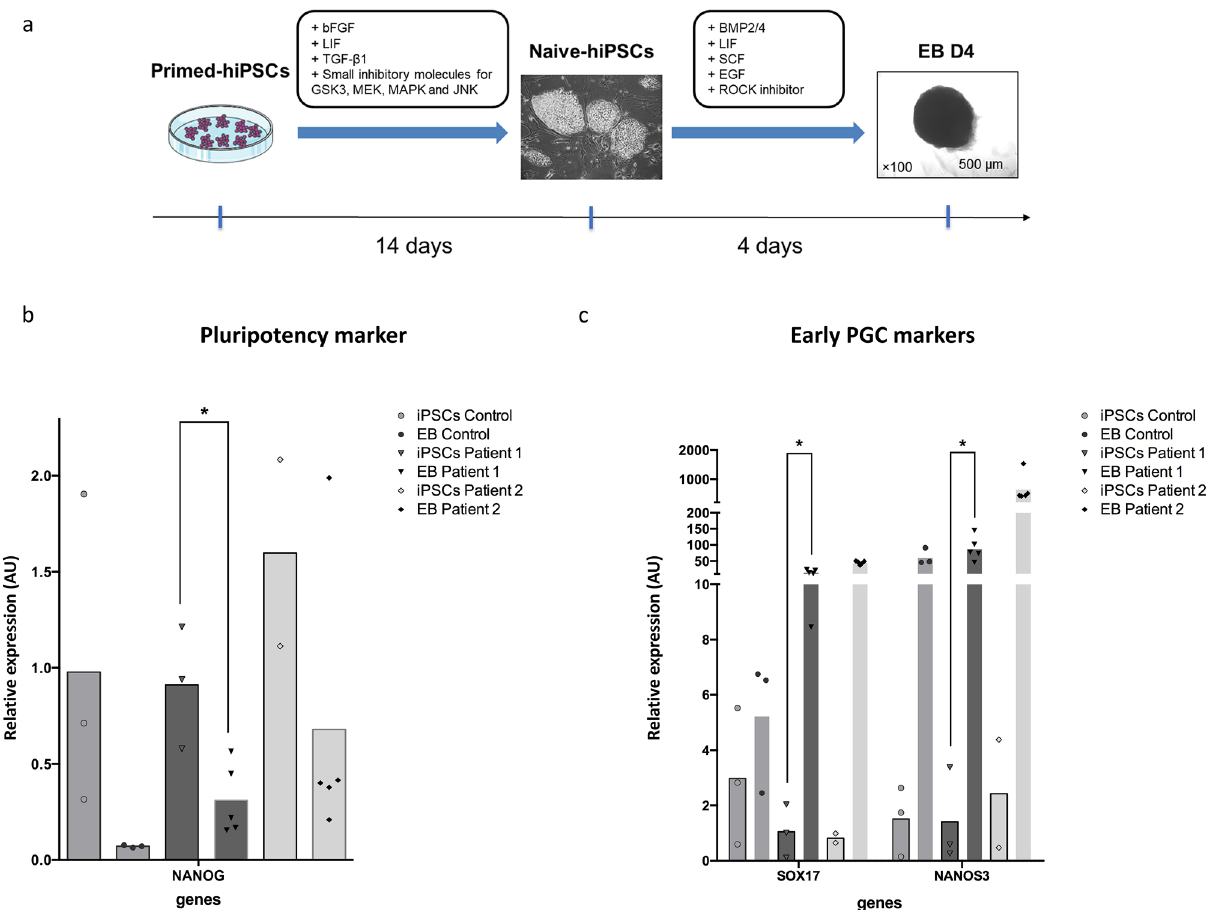
Figure 3. Induction of naive iPSCs state, EB differentiation and gene expression analysis. Timeline of in vitro conversion of primed-hiPSCs into naive-hiPSCs and PGC-LCs differentiation ( a ). RT-qPCR analysis for detection of the pluripotency marker NANOG ( b ); early PGC marker genes SOX17 and NANOS3 ( c ). Relative expression levels are shown with normalization to RPLPO gene. Histograms represent mean from independent biological replicates represented by each point. Mann–Whitney tests were used for PCR analysis. Mann– Whitney tests were performed to compare expression values. *p < 0.05. BMP2/4 bone morphogenetic protein 2/4, EB embryoid body, EB D4 embryoid body day 4, EGF epidermal growth factor, GSK3 glycogen synthase kinase-3, hiPSCs human induced pluripotent stem cells, iPSCs induced pluripotent stem cells, JNK c-Jun N-terminal kinase, LIF leukemia inhibitory factor, MAPK mitogen-activated protein kinases, MEK mitogen- activated protein kinase kinase, SCF stem cell factor, TGF-β1 transforming growth factor